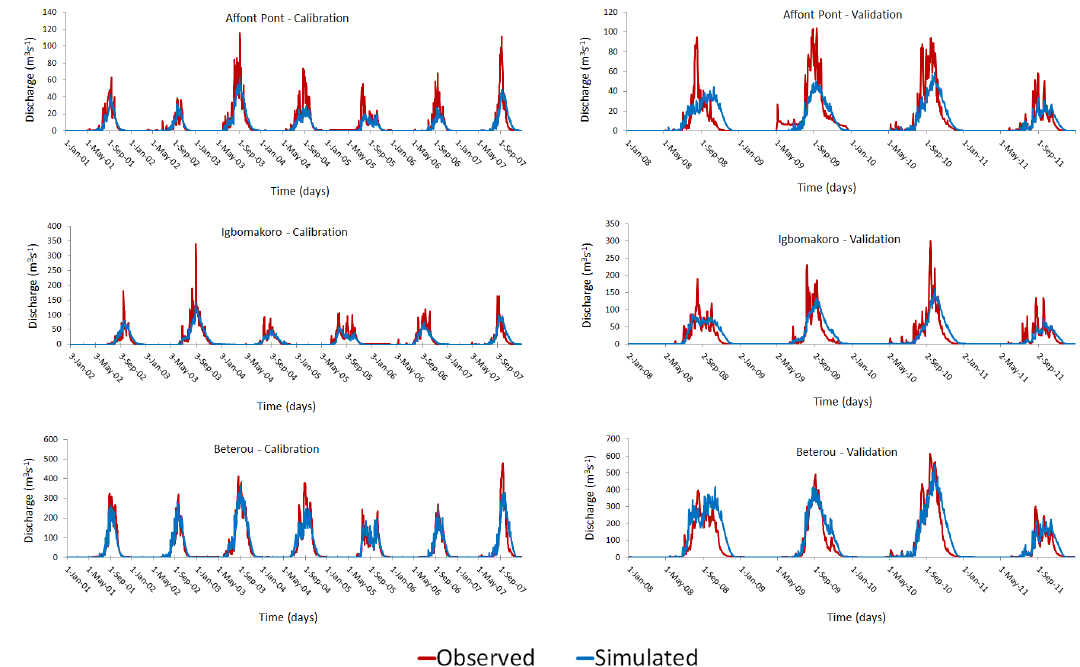
Figure 2. Comparing simulated and observed streamflow for three monitoring stations with varying drainage areas: Affont-Pont, 1172km 2 ; Igbomakoro, 2309km 2 ; Beterou, 10046km 2 .